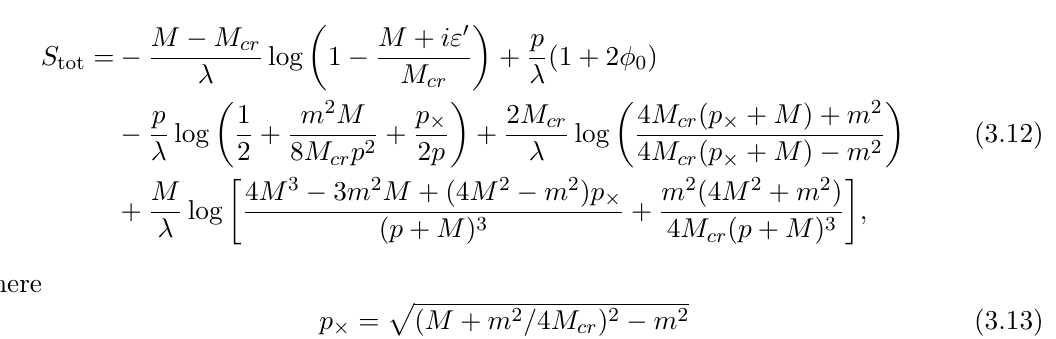
Figure 5 . Real (a) and imaginary (b) parts of the total action (3.12) for m = M m = 0 (dashed) as functions of the particle energy M . The critical black hole mass is M cr = 10 (cid:21) . The interval M < m is kinematically